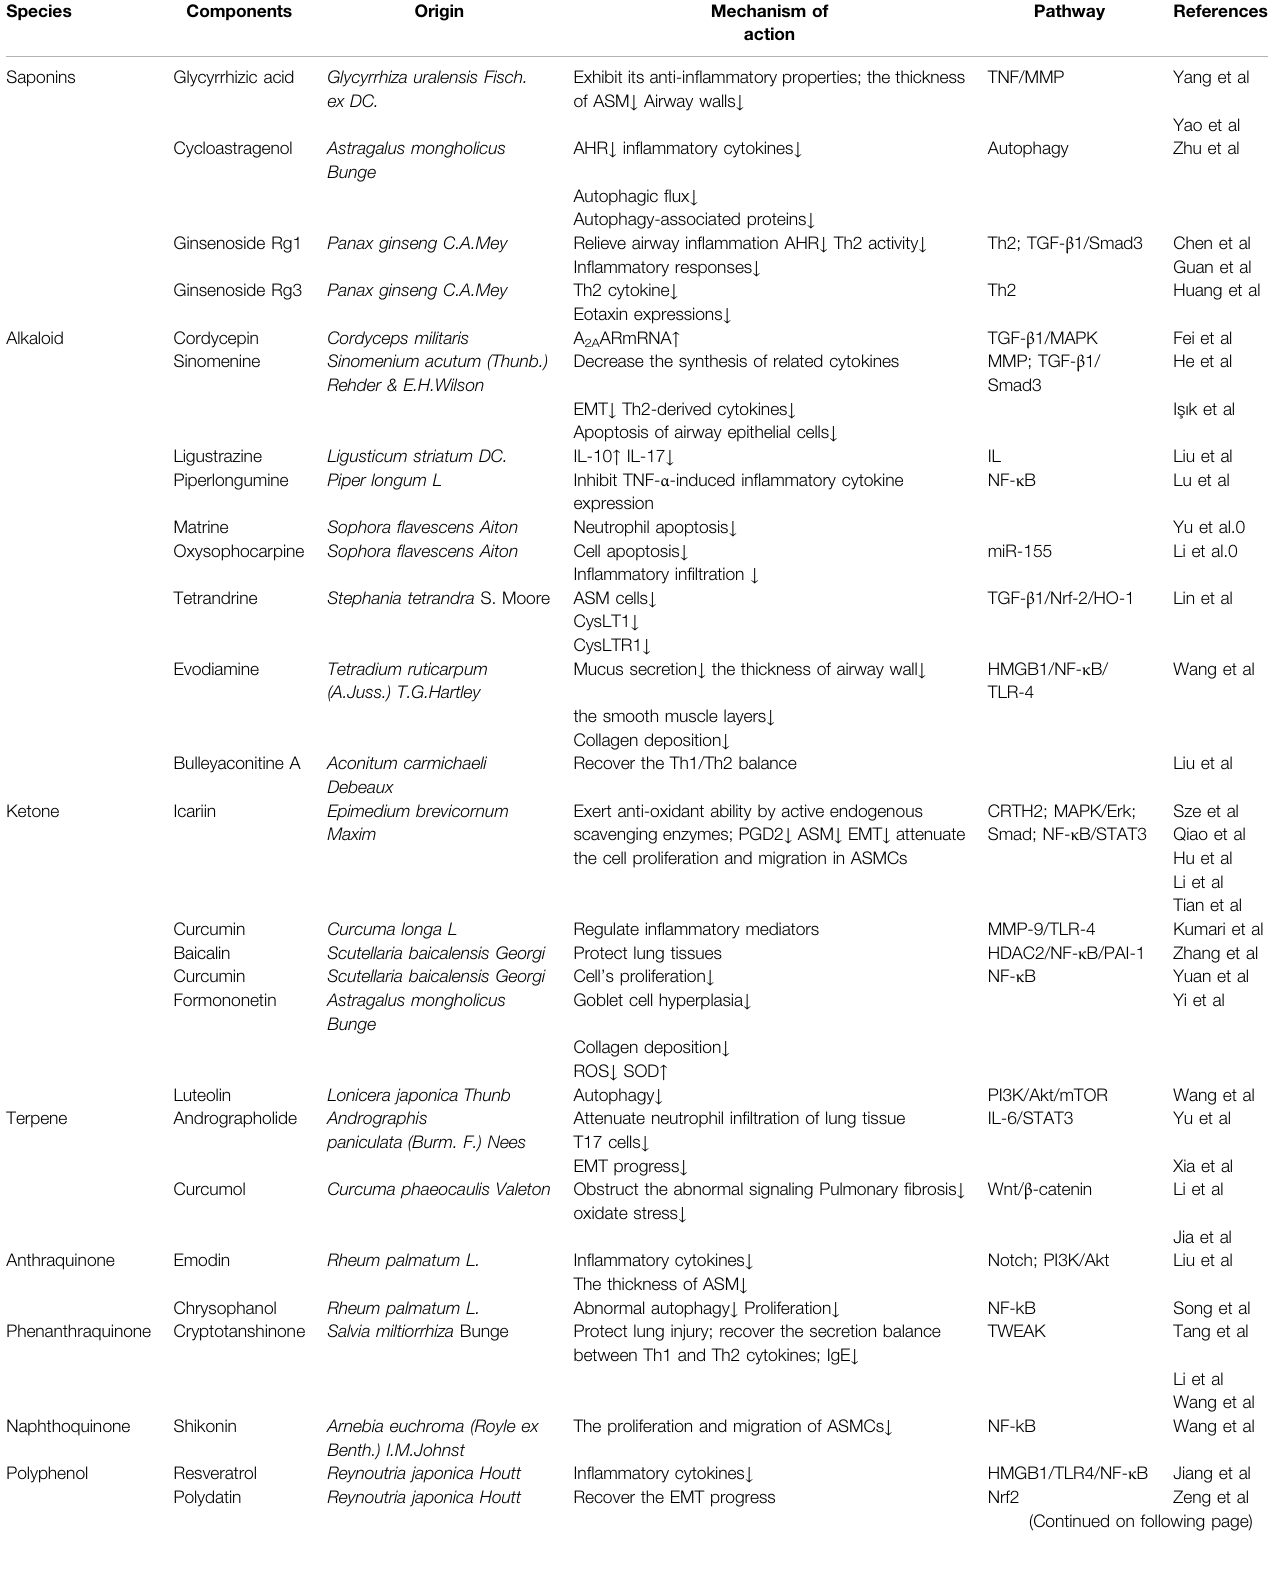
TABLE 3 | The active components from TCM against airway in fl ammation and remodeling.